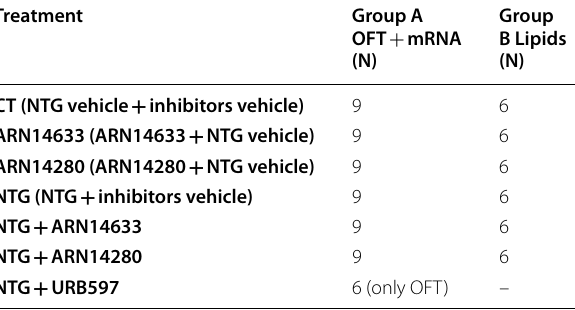
Table 1 Experimental groups and number (N) of animals used in different sets, with different procedures: orofacial formalin test (OFT); gene expression analysis (mRNA); AEA, PEA, OEA and 2-AG level analysis in medulla, cervical spinal cord, and trigeminal ganglion Treatment Group A